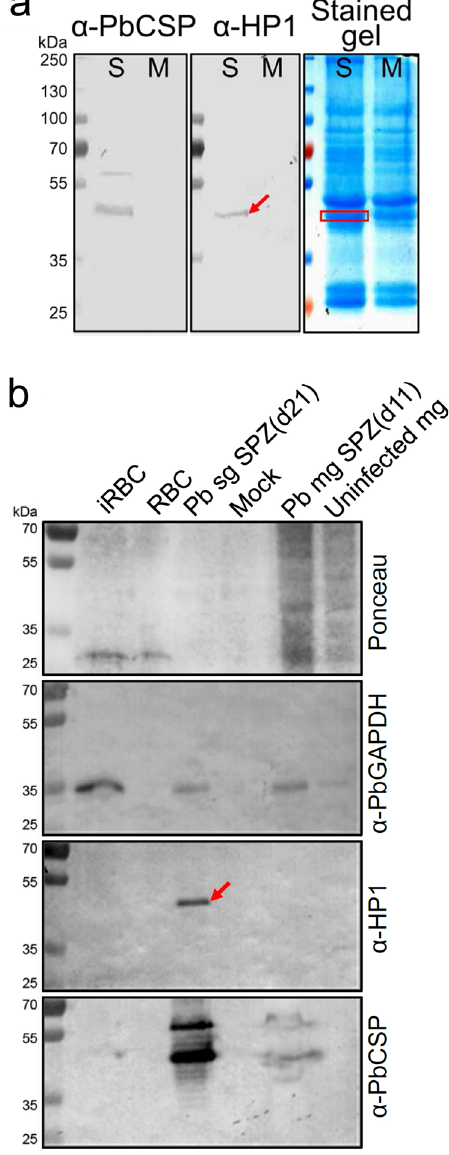
Fig. 4 An anti-HP1 antibody recognizes a ~50 kDa sporozoite ligand protein. a An anti-HP1 antibody recognizes a ~50kDa protein band (red arrow) from sporozoites isolated from infected mosquito salivary glands (S) but not from mock preparations from uninfected mosquito salivary glands (M). A red box on the stained gel denotes the gel piece that was cut for mass spectroscopy analysis. b Anti-HP1 antibody recognizes a protein speci fi c to mature sporozoites. Lysates of asexual blood-stage parasites (iRBC), puri fi ed salivary gland sporozoites (Pb sg SPZ) 21 days after infection, and immature midgut sporozoites (Pb mg SPZ) 11 days after infection were fractionated by SDS – PAGE. Uninfected RBCs, sporozoite preparations from uninfected mosquito salivary glands (Mock), and uninfected midguts were used as controls. Ponceau stain served as a loading reference and an anti-PbGAPDH antibody served as a positive control for P. berghei parasite lysates. The anti-HP1 antibody detected a ~50kDa protein only from salivary gland sporozoites (red arrow). a and b Each image represents two independent repeats. Source data are provided as a Source Data fi